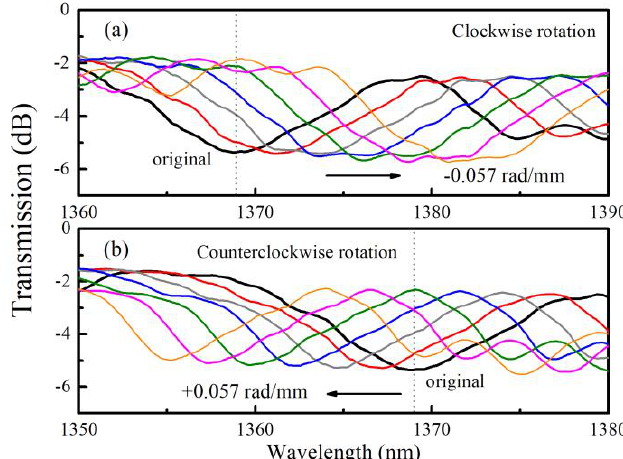
Figure 10. Transmission spectra of LFTPCFs filled with standard RI liquid as well as RIs that varied from 1.482 to 1.488 in intervals of 0.002.